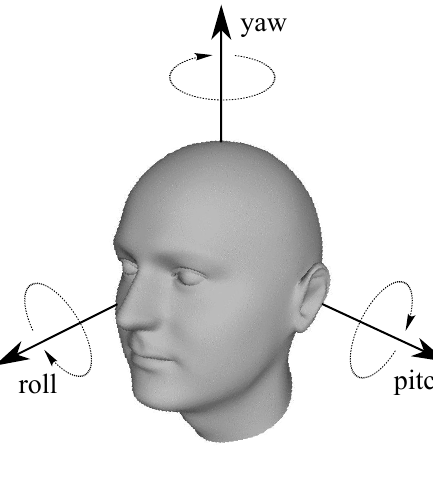
Figure 3. Head pose can be decomposed in pitch, yaw and roll